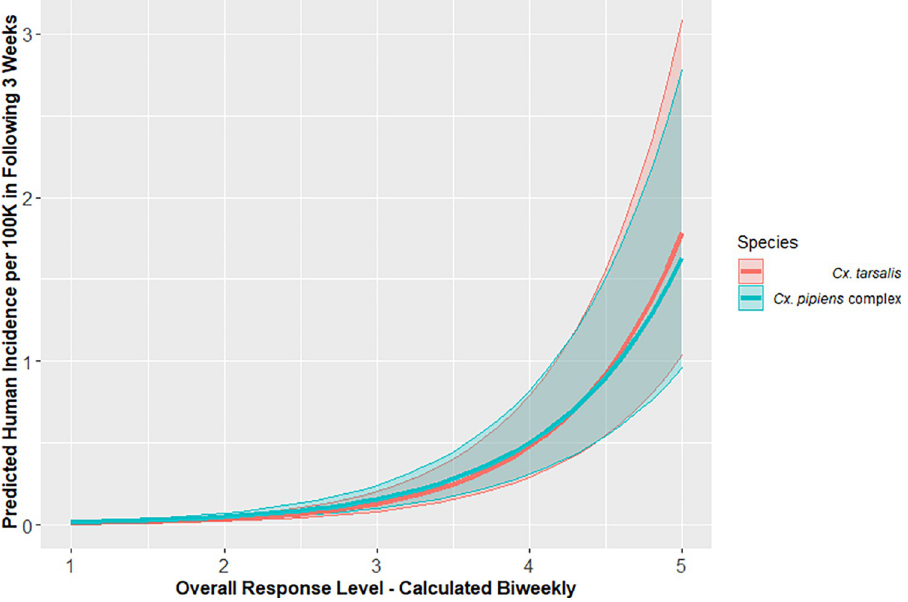
Fig 4. Predicted incidence of human WNV disease with 95% confidence interval during 3-week periods over the range of biweekly overall risk levels for California, 2009–2018. https://doi.org/10.1371/journal.pntd.0010375.g004 Sufficient data were available to calculate vector index values from 34 VCAs, yielding observed values for 6,600 biweekly periods, the same time scale as response levels. Most obser- vations (56.4%) of vector index for Cx . pipiens complex were 0, with a mean of 77.2 (range: 0–- 25,954), whereas 65.1% of observations of vector index for Cx . tarsalis were 0, with a mean of 40.5 (range: 0–2,709). To reduce the influence of outliers, the data was subset to vector index observations � 1,000, which left 98% of observations for both Cx . pipiens complex (1,528/ 1,561) and Cx . tarsalis (1,307/1,330). Models based on a response level had a lower AIC than the associated model based on vector index for the same species. The AIC of the regression model based on Cx . pipiens complex vector index was 1,336 higher than that which was based on response level, while the Δ AIC for Cx . tarsalis vector index model was 1,421 higher than the